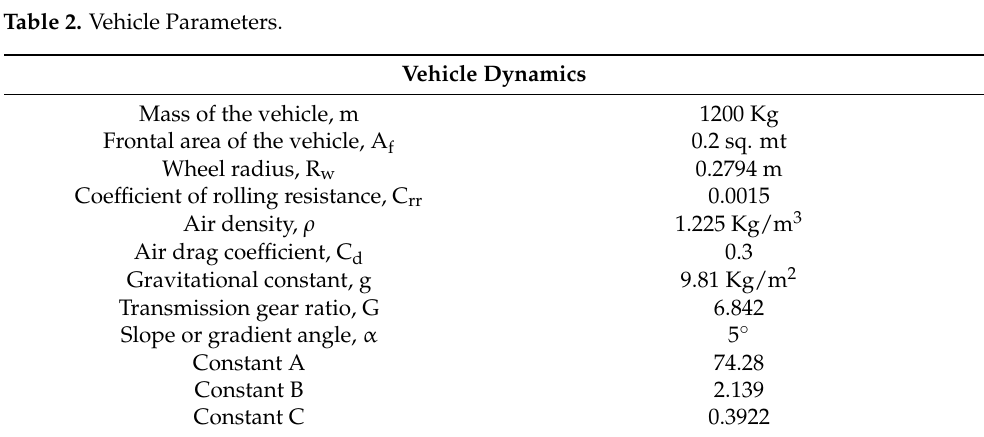
Table 2. Vehicle Parameters.